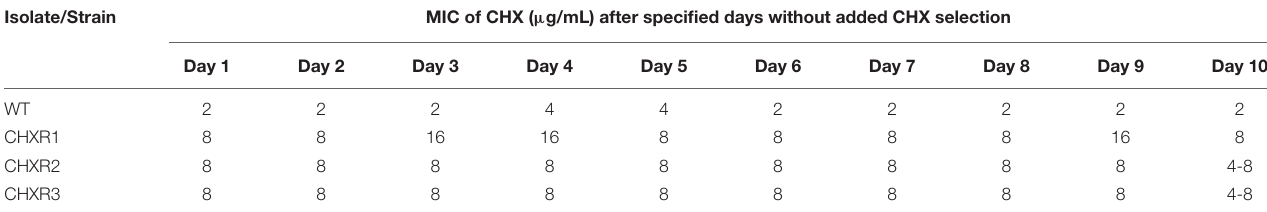
TABLE 3 | A summary of MIC values determined for each CHX-adapted isolate after 1–10 days of growth without CHX selection in LB growth medium. Isolate/Strain MIC of CHX ( µ g/mL) after specified days without added CHX